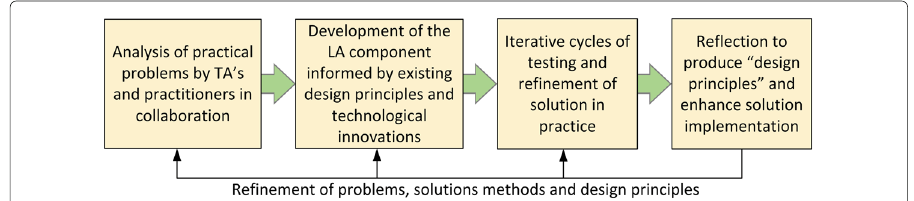
Fig. 7 Phases of design